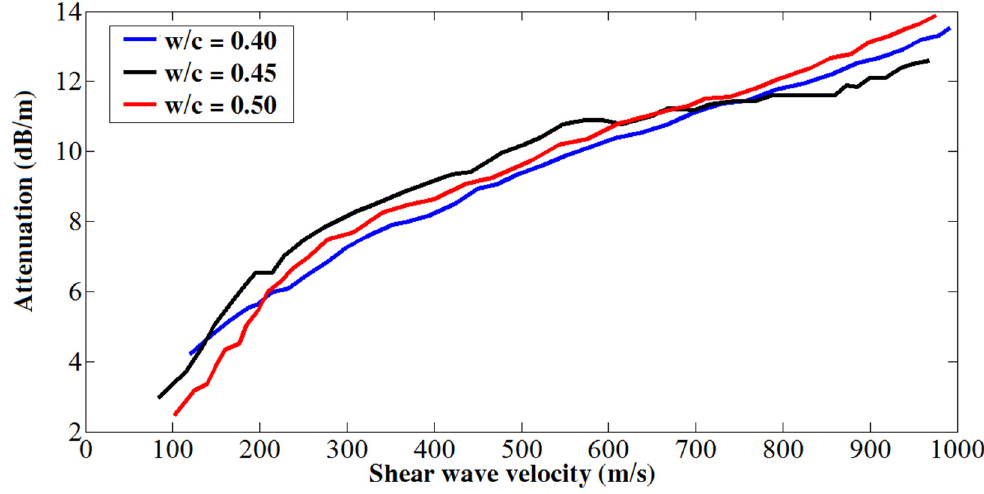
Figure 8. Correlation between shear wave velocity and attenuation.